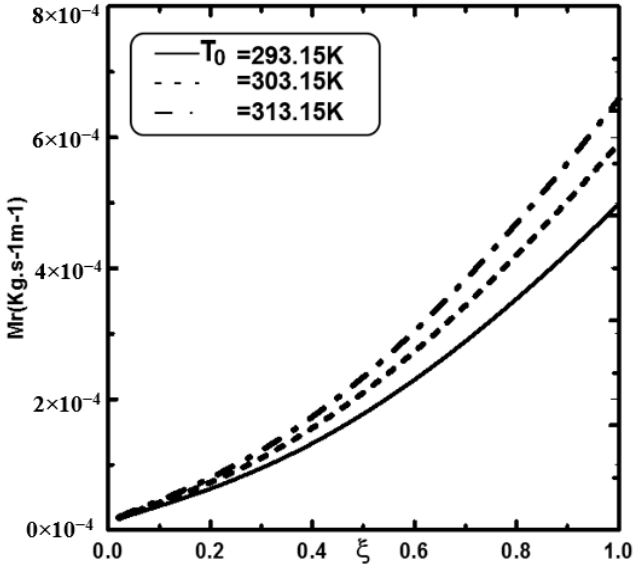
Figure 13. Variation of the cumulated evaporation rate to various inlet gas temperature: T 0L = 293.15 K, q 1 = 3000 W/m 2 , T w = 293.15 K, c 0 = 0, p 0 = 1 atm, m 0L = 15 × 10 − 4 Kg/m · s, H = 1 m, d = 0.015 m, u 0 = 1 m/s, φ 0 = 0.03